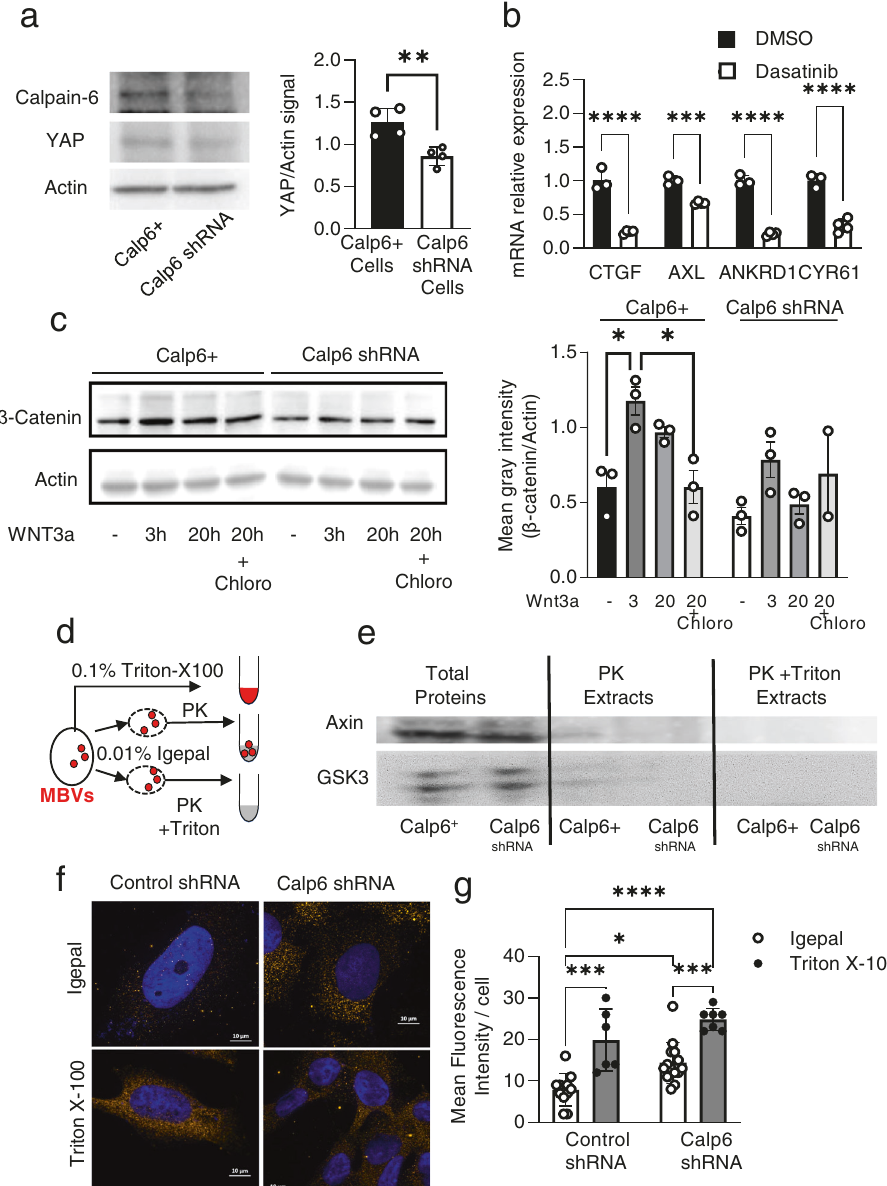
Fig. 2 Calpain-6 stabilizes YAP protein. a Proteins were extracted from Calp6 + and Calp6 shRNA cells and used for Calpain-6 and YAP immunoblot assays. Actin was a loading control. Panel on the right shows the quanti fi cation of 4 different Western blots. b Effect of Hippo pathway activation with Dasatinib on the expression of YAP/TEAD targets as indicated in calpain-6 overexpressing 143B cells. Control cells were treated with the eluent DMSO. Results are expressed as mean fold changes ( ΔΔ Ct) ± SEM. c 143B cells were treated with medium conditioned on WNT3a-producing cells or control cells in the presence of DMSO or chloroquine. Protein extracts were prepared 3 or 20 h after Wnt stimulation for β -catenin immunoblot assay. Results are mean ± SEM relative grey intensity of β -catenin to actin from 3 independent blots. d Proteinase K protection assay. Cells were lyzed with triton X-100 to obtain whole protein extracts or with a soft detergent to prepare intact multivesicular bodies (MBVs). Proteinase K (PK) was added to digest proteins that were not protected into MBVs. The addition of Triton with PK served to control MBV-dependent protection. e , Immunoblots for Axin and GSK3 in the 3 types of protein extracts. f , GSK3 immuno fl uorescence in Calp6-P-GFP + 143B cells expressing control or Calp6 shRNA. The cells were permeabilized with Igepal or Triton X-100 before incubation with anti-GSK3 antibodies. Dapi served to stain the nuclei. g , Quanti fi cation of the mean fl uorescence in GFP + cells. *, *** and **** indicate signi fi cant difference, p < 0.05, p < 0,001 and p < 0,0001,